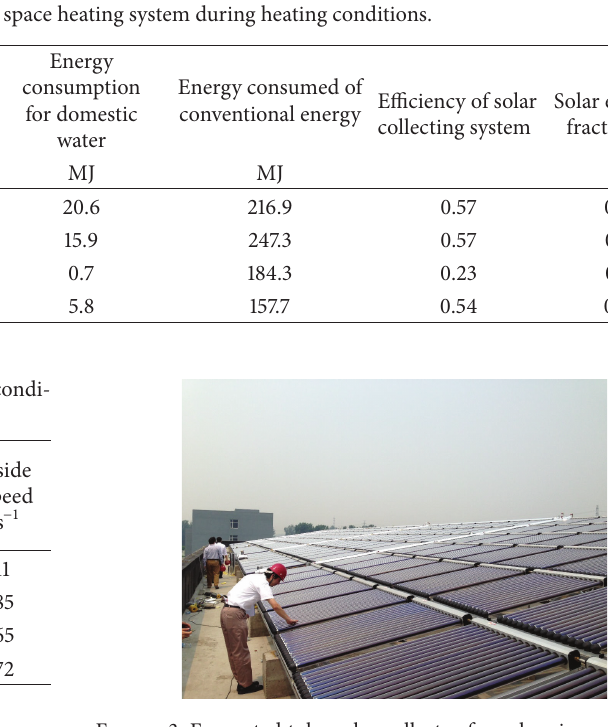
Figure 3: Evacuated tube solar collector for solar air-conditioning system in